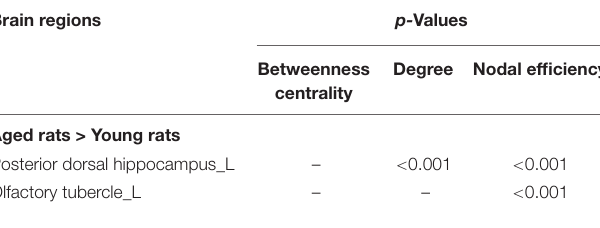
TABLE 2 | Intergroup differences of regional network